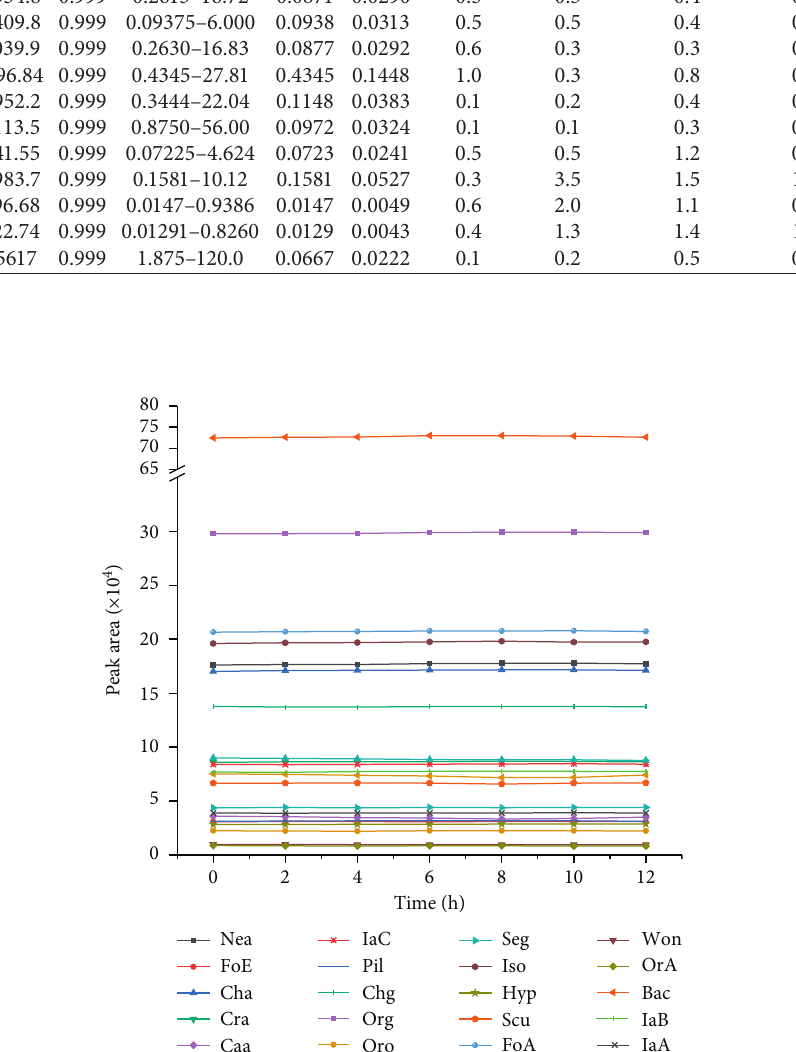
y � 10864 x − 3542.2 0.999 FoA